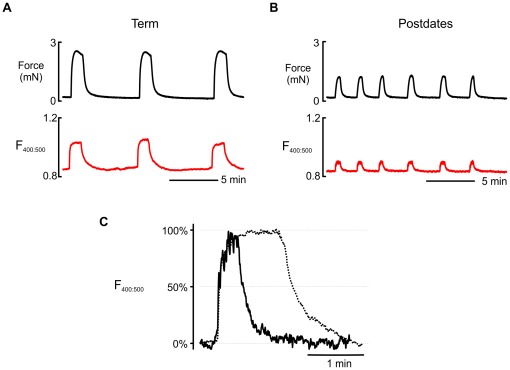
Contractile activity and Ca signalling in term and postdates non-labouring myometrium.Simultaneous recordings of spontaneous contractile activity (top, black trace) and intracellular Ca transients (Indo-1, ratio of fluorescence at 400∶500 nm, bottom, red trace) of myometrial strips obtained from women undergoing planned pre-labour CS at (A) term (39–41 weeks) and (B) postdates (≥41weeks+3). This example shows a term sample contracting particularly strongly to emphasize the difference in Ca signals. Inset (C) below on expanded time scale shows an overlay of Ca transients normalised by amplitude showing significantly reduced transient duration in postdates myometrium (solid black line) compared to term myometrium (dotted black line).